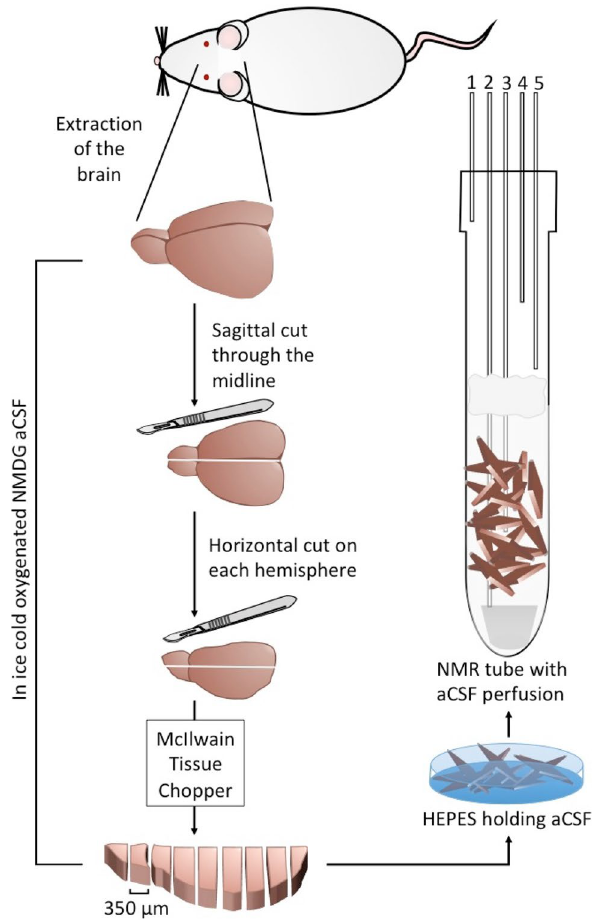
Figure 1. Schematic drawing of the surgery and the cerebrum slicing procedure. Following brain extraction, separation of the cerebellum, slicing of the cerebrum, and recovery period in HEPES-holding aCSF, the cerebral slices were placed in a 10 mm NMR tube with continuous perfusion of aCSF (Solution 3 below) and bubbled with 95%/5% O 2 /CO 2 at 37 °C at a rate of 4 L/min. The lines going in and out of the NMR tube are marked as follows: 1. Humidified 95%/5% O 2 /CO 2 atmosphere; 2. aCSF inflow line; 3. NMR compatible temperature probe; 4. Backup aCSF outflow line; 5. aCSF out-flow line. A filter made of cotton balls (colored gray in the Figure) was placed a few cm above the slices to prevent suction of the occasional floating slice into the out-flow lines. The slices were kept at the bottom of the tube at the region visible to the NMR probe due to gravity and possible inter-slice adhesion and the gentle perfusion generally did not displace them. A spacer made of solid PEEK was placed at the bottom of the tube prior to placing the slices in the NMR tube. This was done to raise the slices to the level observed by the NMR probe without the introduction of susceptibility differences at the region of the probe, thereby optimizing the use of cerebral tissue in each